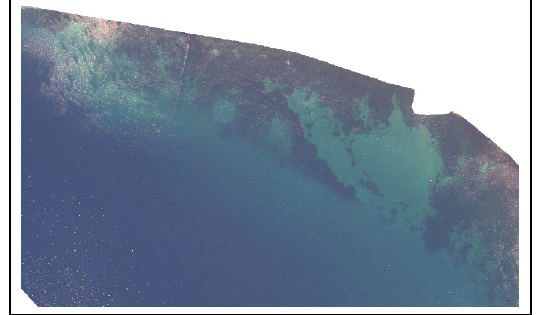
Figure 1. The study image area (R:4, G:3, B:2) The imagery data set included the eight (8) bands of Worldview-2 multispectral image. The image was acquired in 16 June 2010 with spatial resolution of 2m. Despite the water clarity, the depths estimation was constrained by image noise that sun glint caused by appearing sparsely in a great part of image scene. The available data were georeferenced to UTM (zone 34) system and WGS84. The study area included only the water region of the image (fig.1). From now on, the 8 bands of the image will be symbolized as: band 1 (coastal), 2 (blue), 3 (green), 4 (yellow), 5 (red), 6 (red-edge), NR1 (first near- infrared) and NIR2 (second